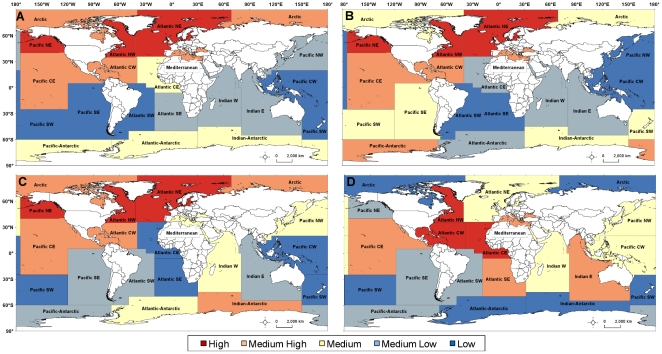
Relative abundance of records per square km published on SEAMAP in FAO statistical fishing areas.Abundance for: (A) all marine mammals, seabirds, and sea turtles; (B) marine mammals; (C) seabirds; and (D) sea turtles. Each color represents one quintile (hot to cool colors: red, orange, yellow, light blue, and dark blue), containing the number of records that fell into the >79th (high), 79-60th (medium-high), 59-40th (medium), 39-20th (medium-low), and <20th (low) percentiles, respectively. See Table 1 for FAO global statistical fishing area codes and regions.